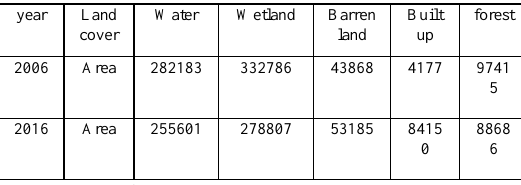
Table 2: Area of landcover classes at Indus delta